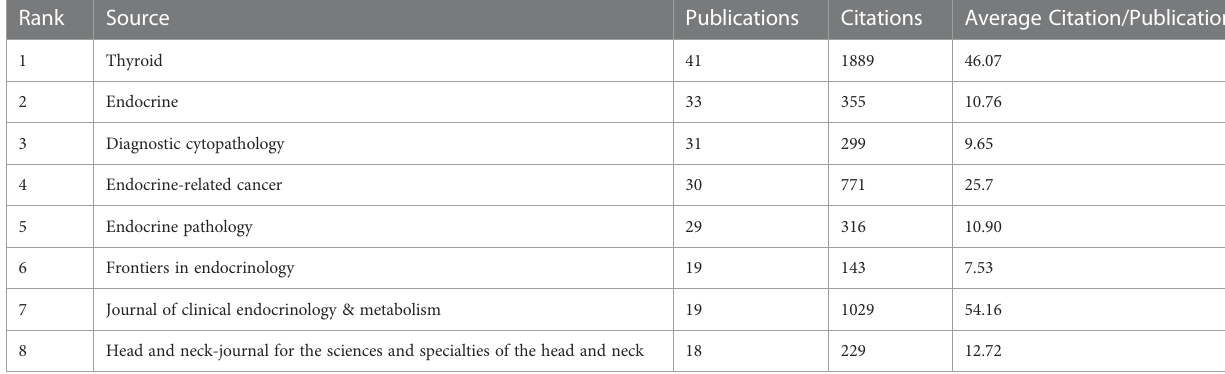
TABLE 4 Top 8 journals in the MTC research fi